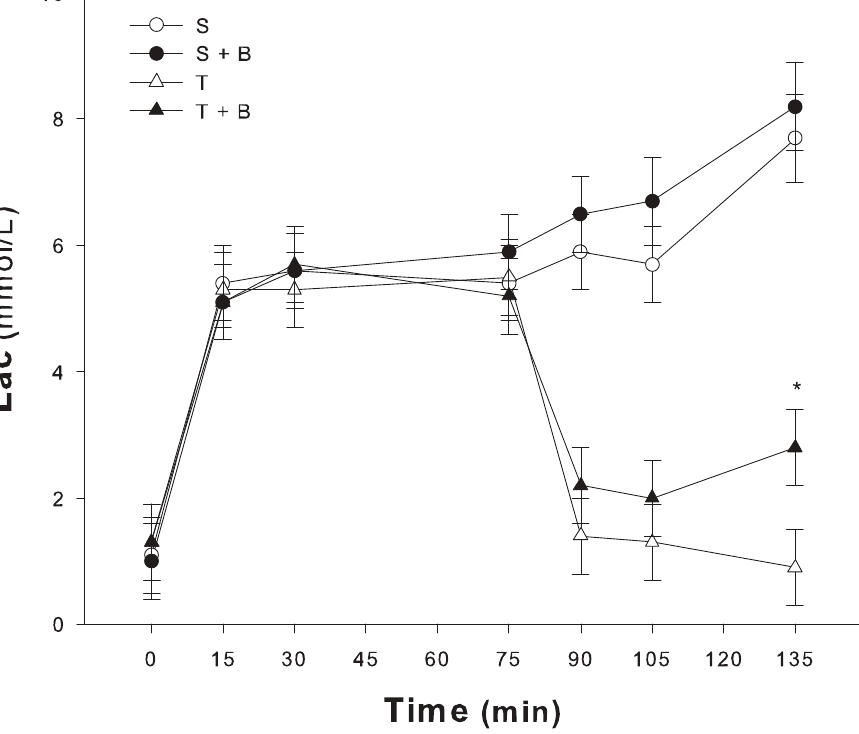
Figure 2. Lactate over time in the four groups. Lactic acid load caused blood lactate to rise in all groups ( # P , 0.05 vs. time 0). After 135 minutes in the sustained groups blood lactate remained high both in the sustained (S) and the sustained + NaHCO 3 (S + B) group. In the transient (T) groups blood lactate levels after 135 minutes were different from values at time 75 minutes ( u P , 0.05). Animals that received NaHCO 3 (T + B) had higher lactate levels (* P , 0.05 vs. transient